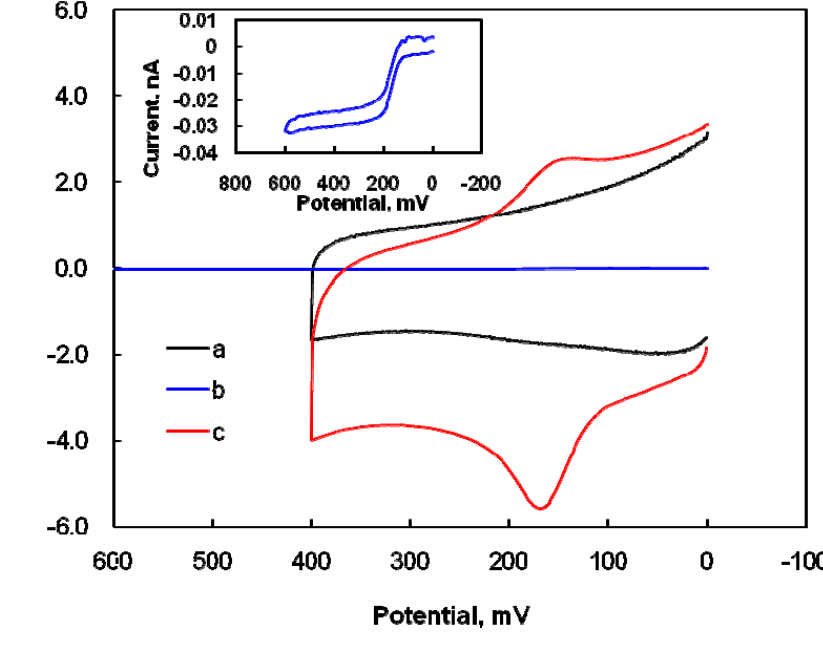
Figure 1. Cyclic voltammograms of a blank PBS solution: (a) at the modified microelectrode; (b) for the electrochemical response of 10  M DA at a bare CFME and (c), at the modified microelectrode in PBS solutions at pH 7.4 with a scan rate of 10 mV/s. Inset: enlargement of